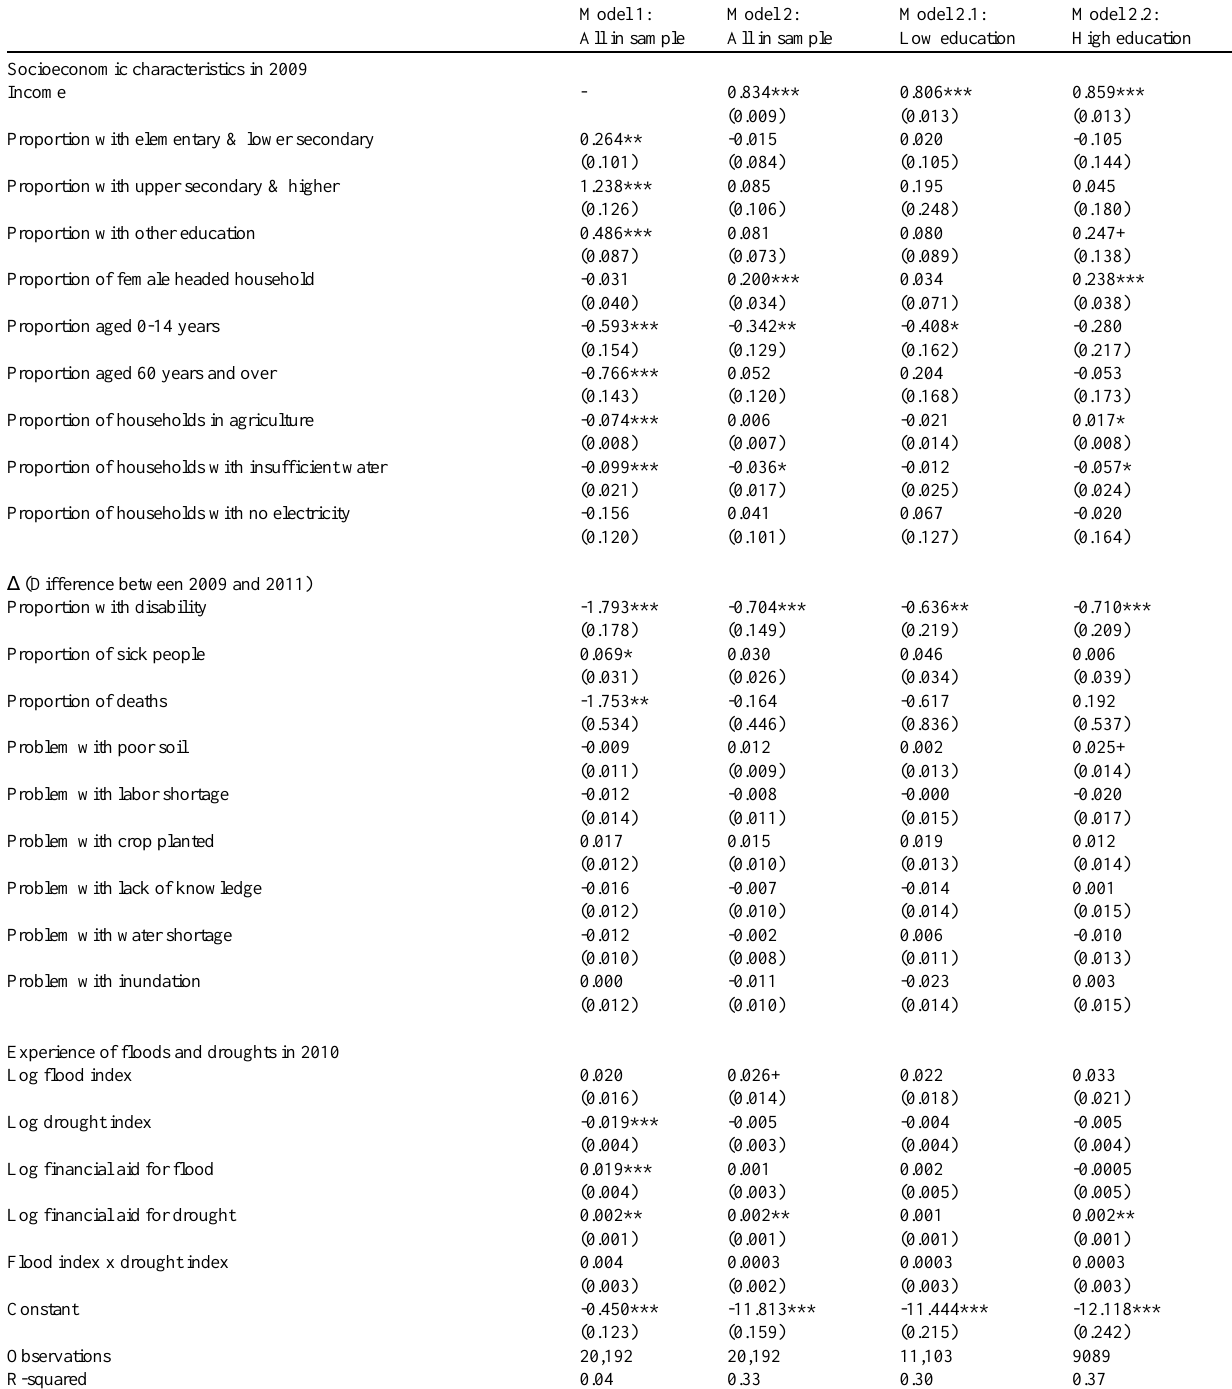
Table 5 . Difference-in-difference estimates of income (standard errors in parentheses): effects of government financial